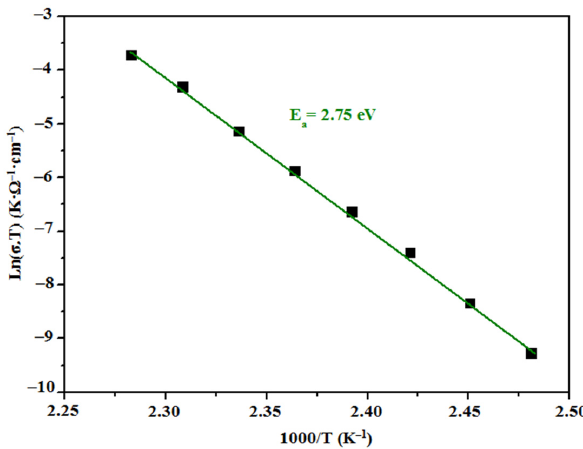
Figure 12. Ln( σ ·T) versus (cid:2869)(cid:2868)(cid:2868)(cid:2868)